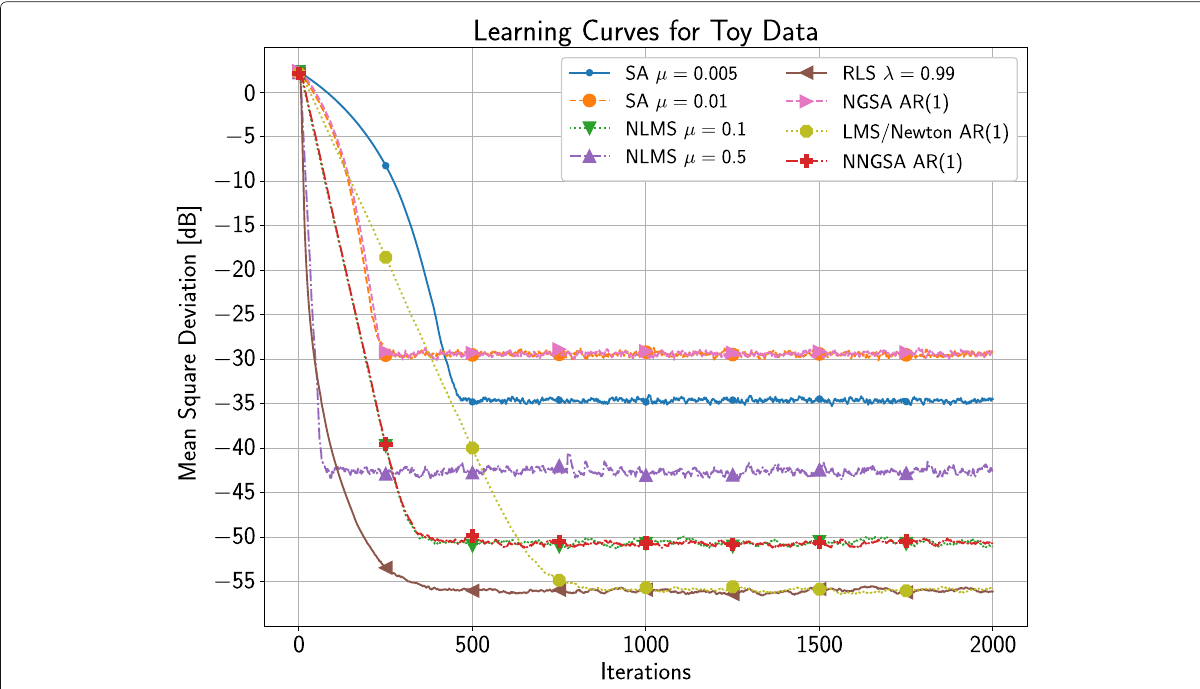
Fig. 6 Learning curves for white-Gaussian-noise